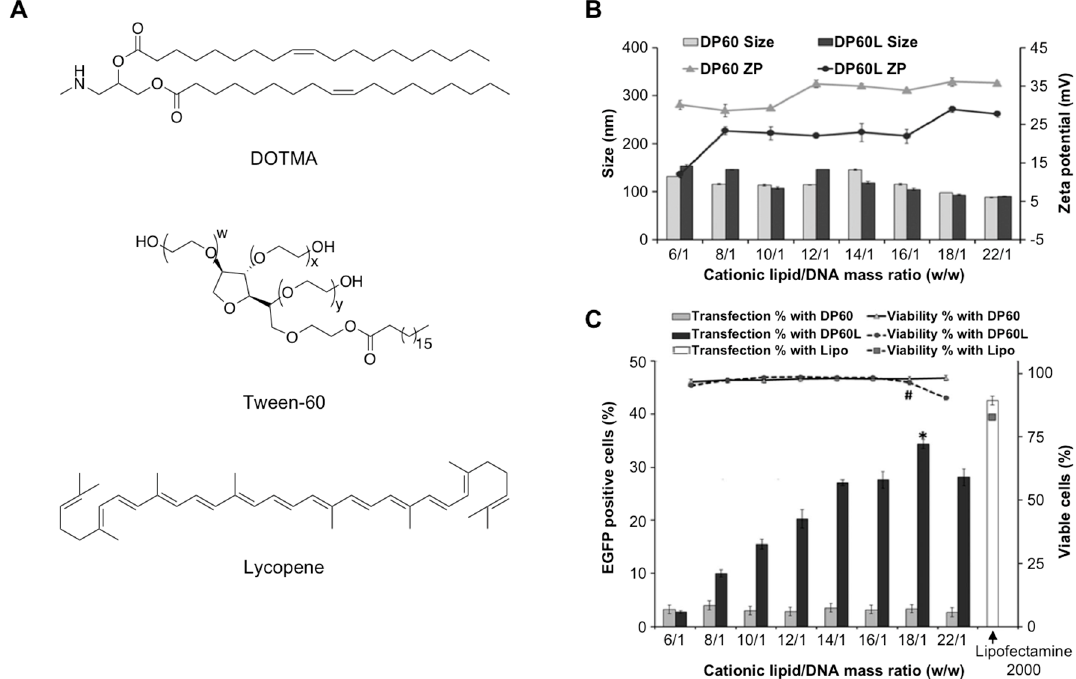
Figure 4. Particle characterization and in vitro gene transfection experiments mediated by niosomes made up DOTMA, Tween-60 and Lycopene. ( A ) Chemical structures; ( B ) particle size and zeta potential of nioplexes; ( C ) cellular viabilities and gene transfection after 72-h incubation in ARPE-19 cells. Control positive was carried out with lipofectamine. Adapted with permission from ref. [78]. Copyright 2017, Elsevier B.V.